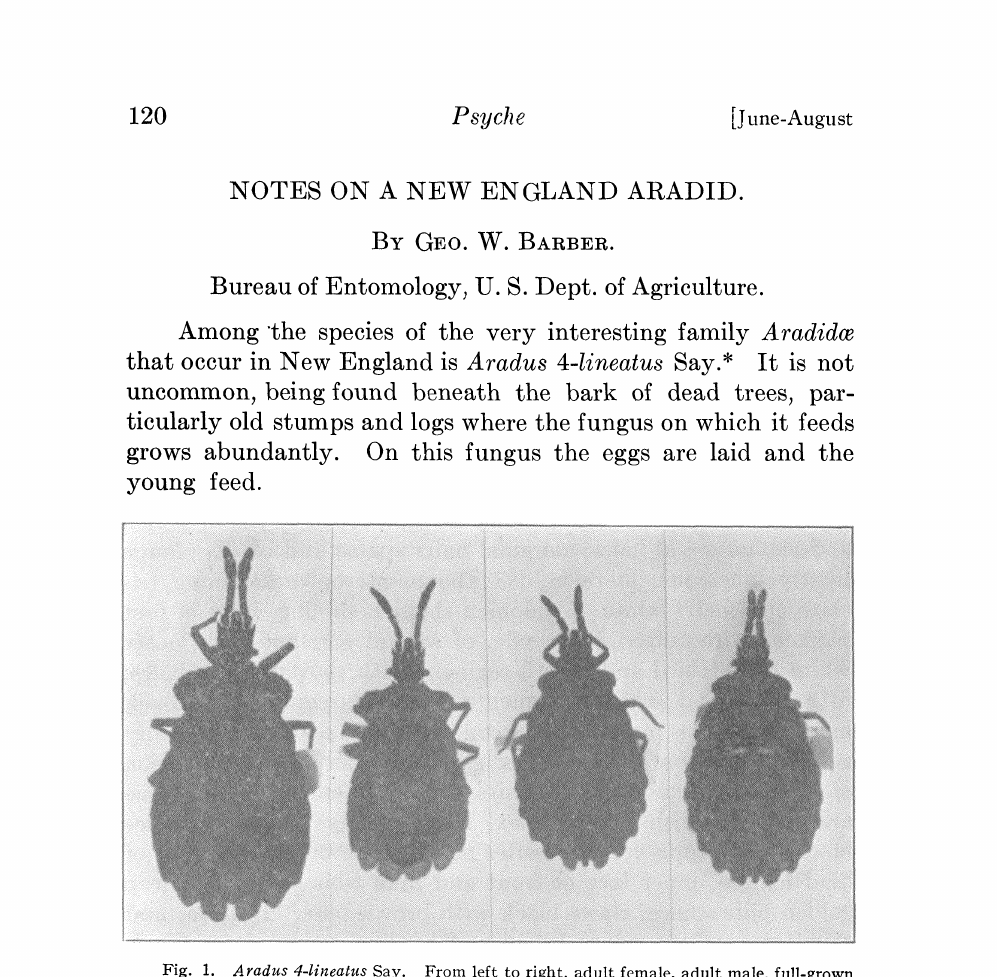
Fig. 1. Aradus 4-lineatus Say. From left to right, adult female, adult male, full-grown